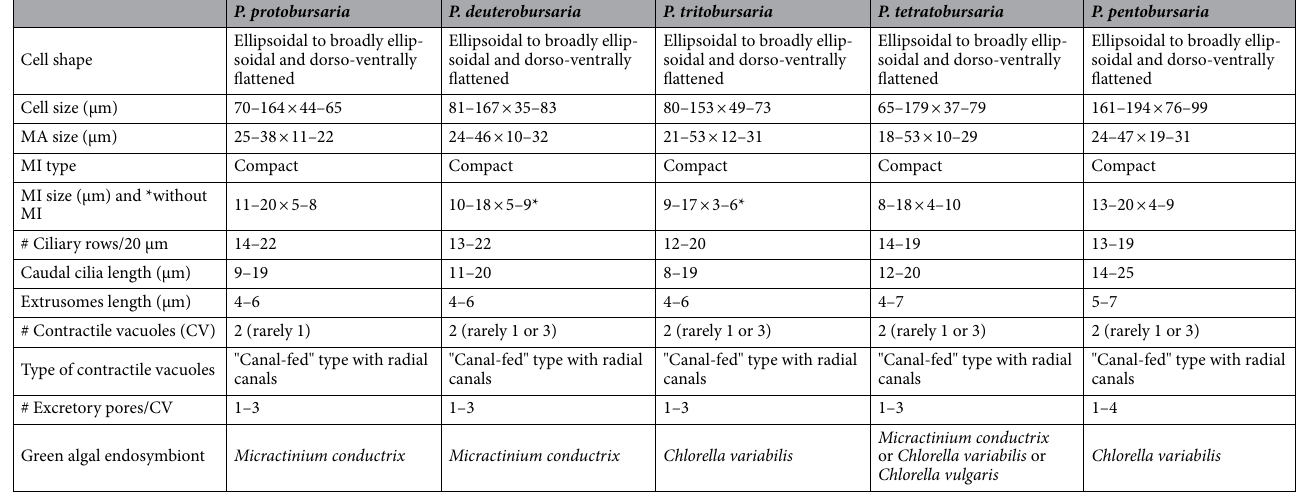
Table 1. Main morphometric and morphological characteristics of the Paramecium bursaria syngens (min and max values). The asterisk indicates that a micronucleus was not seen in live specimens in one of the investigated strains (see Table S2 for